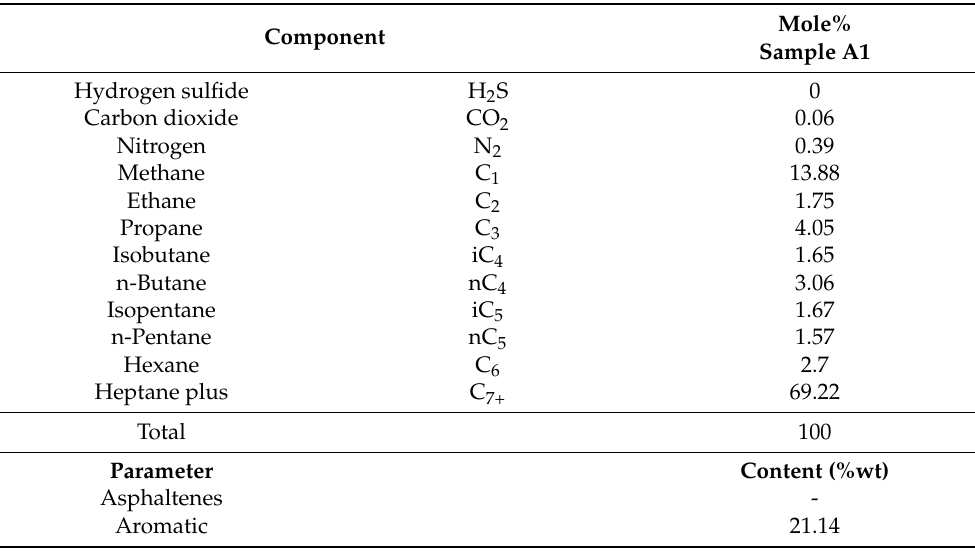
Table 2. Crude oil sample composition at reservoir condition and generalized